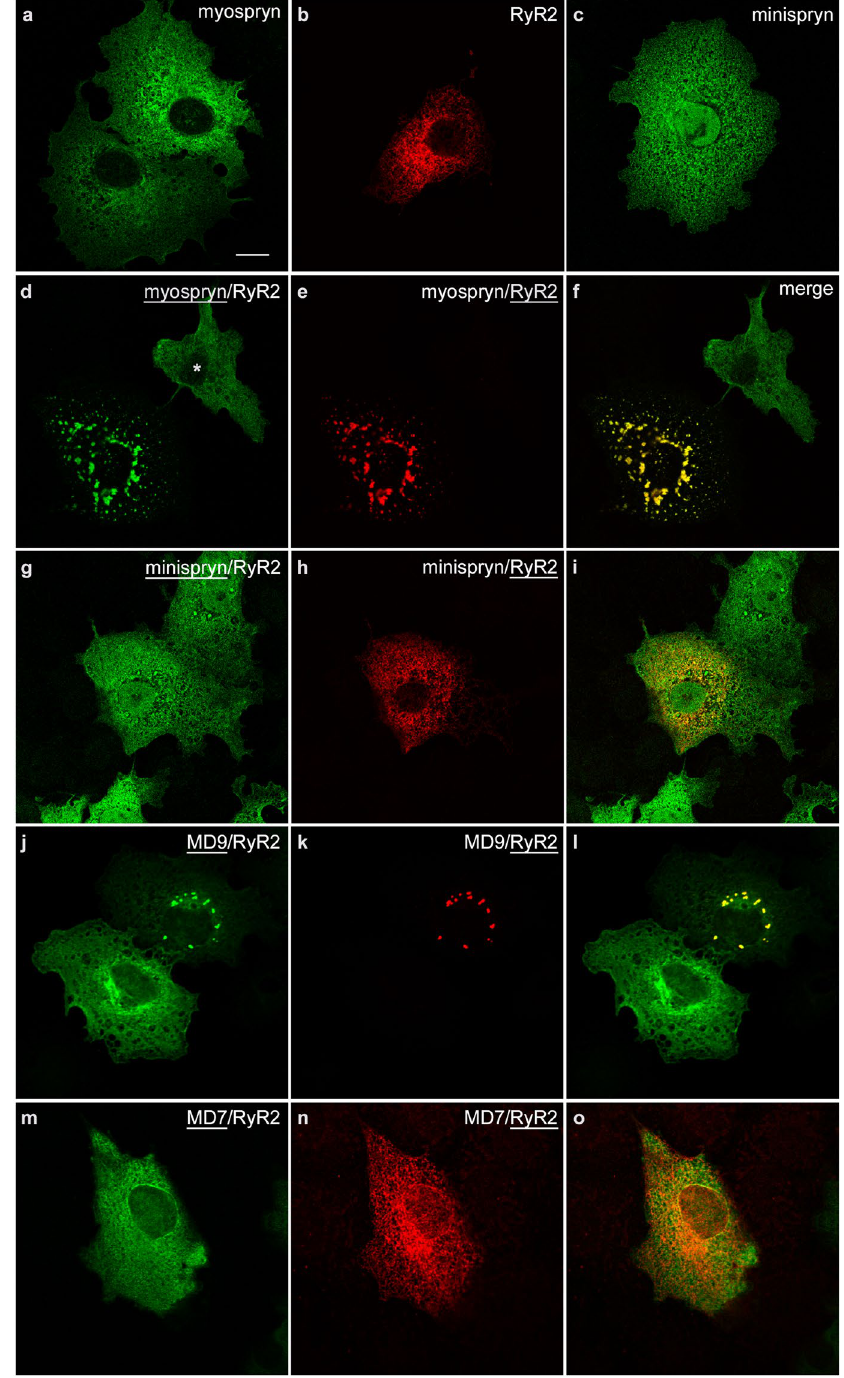
Figure 5. Myospryn clusters RyR2 in heterologous cells. COS-7 cells were transfected with expression constructs as indicated. ( a – c ) Full-length myospryn (a) and minispryn (c) appear to be associated with the internal membranes of the cell when expressed on their own whereas RyR2 (b) labelling is restricted to the endoplasmic reticulum. ( d – f ) Co-expression of myospryn (d) and RyR2 (e) results in the clustering of both proteins in intensely staining punctae (merged image, f). Note that myospryn is not clustered in the adjacent cell (asterisk) that does express RyR2. ( g – i ) By contrast co-expression of minispryn (g) and RyR2 (h) does not alter the distribution of either protein (merged image, i). ( j – o ) Truncated myospryn constructs were used to delineate the regions of the protein involved in RyR2 clustering. MD9 (j) was able to cluster RyR2 (k and merged image, l) whereas the smaller protein MD7 (m) failed to cluster the receptor (n and merged image, o). The underlining denotes the transfected construct for each channel. Scale bar = 10 µ